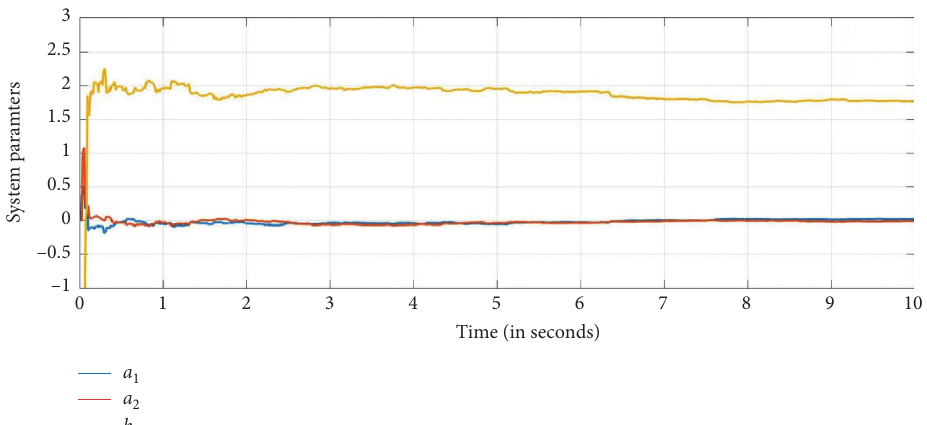
Figure 6: The identification result of the system parameters, parameters a the coefficient of the input term.